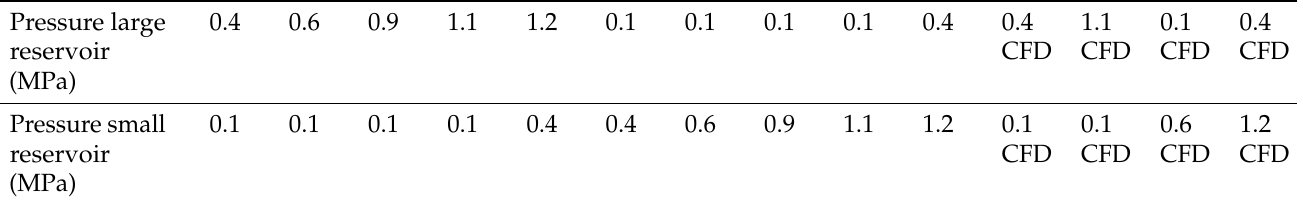
Table 1. Initial absolute pressure at both reservoirs for all different experimental tests performed and for all Computational Fluid Dynamic (CFD) simulations